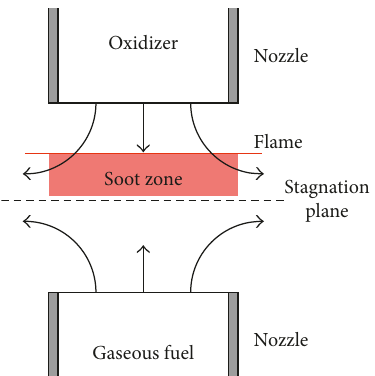
Figure 1: Configuration of counterflow diffusion